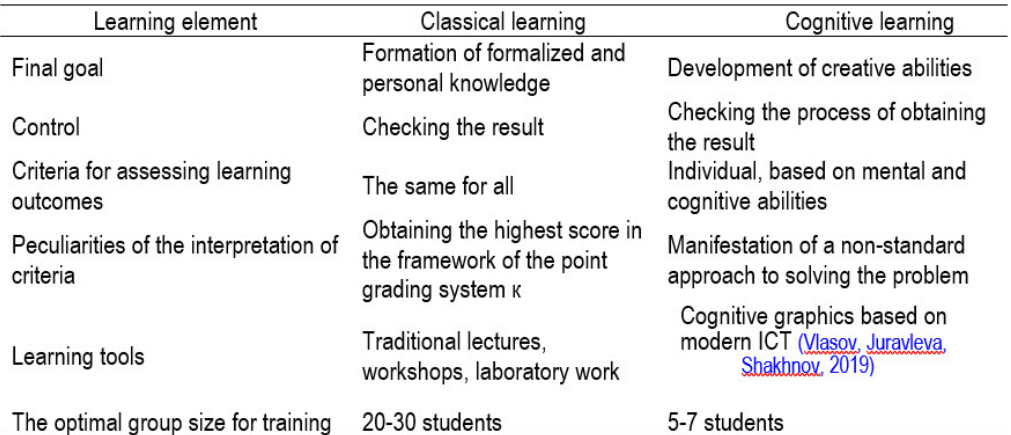
Comparative analysis of classical learning and cognitive